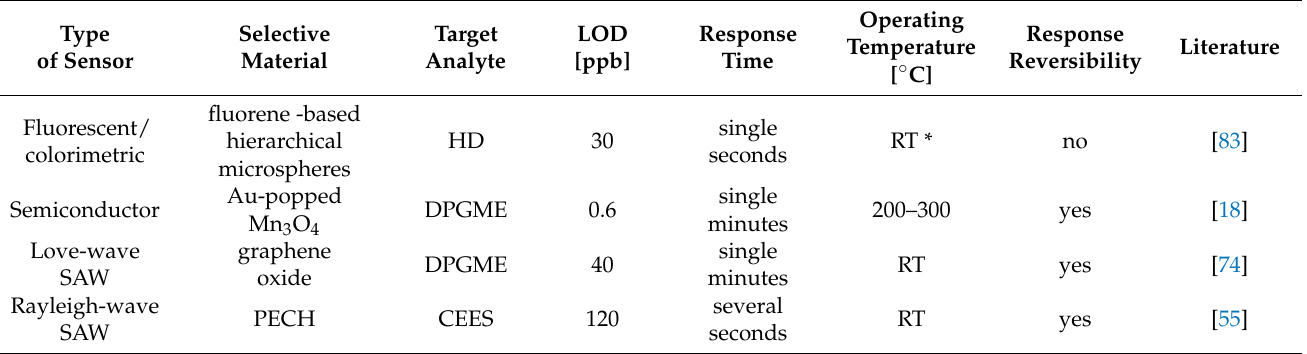
Table 3. Comparison of different types of sensors enabling the detection of blister agents and their simulants in the gas